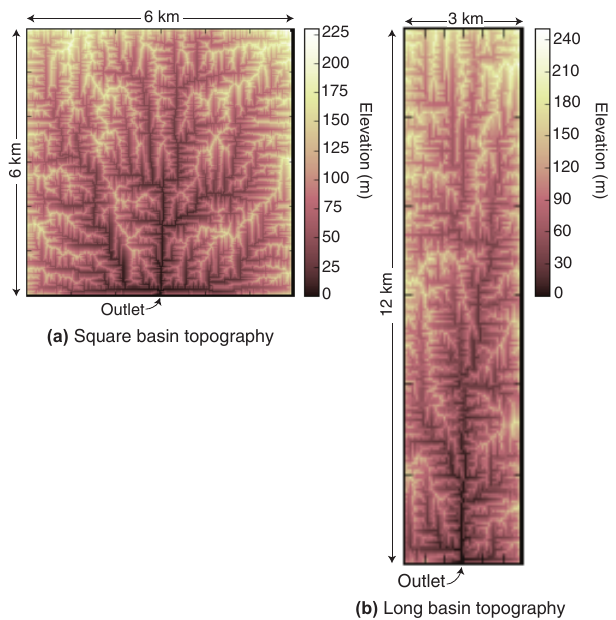
Figure 9. Two test basins evolved using the Landlab FlowRouter and StreamPowerEroder components (not described here; see Hob- ley et al., 2017), generating a network using D4 flow routing and erosion methods. Each grid was evolved from an initial random to- pography to steady state, where uplift rate is matched by incision rate. Both basins have the same drainage area (36km 2 ) at the water- shed outlet but different dimensions: panel (a) has 200 rows 200 × columns, and panel (b) has 400 rows 100 columns. Both have a × grid resolution ( (cid:49)x ) of 30m. Note the perpendicular junctions are due to the D4 flow routing